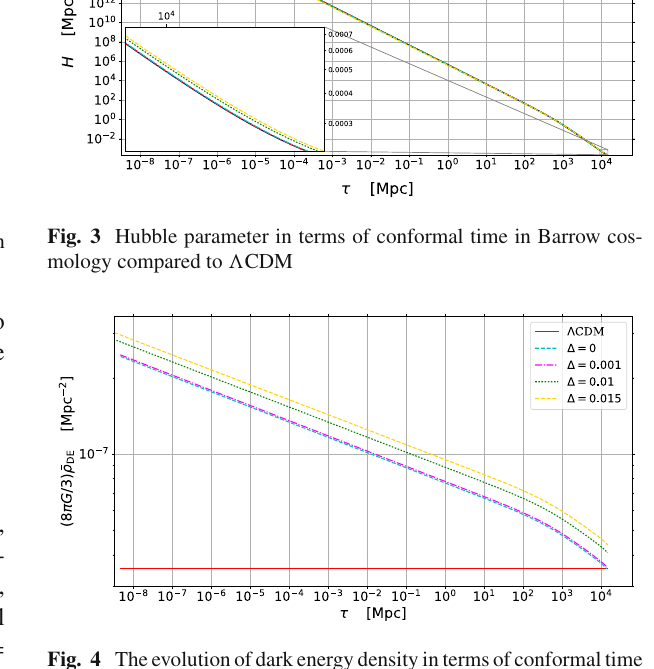
4 Comparison with observational